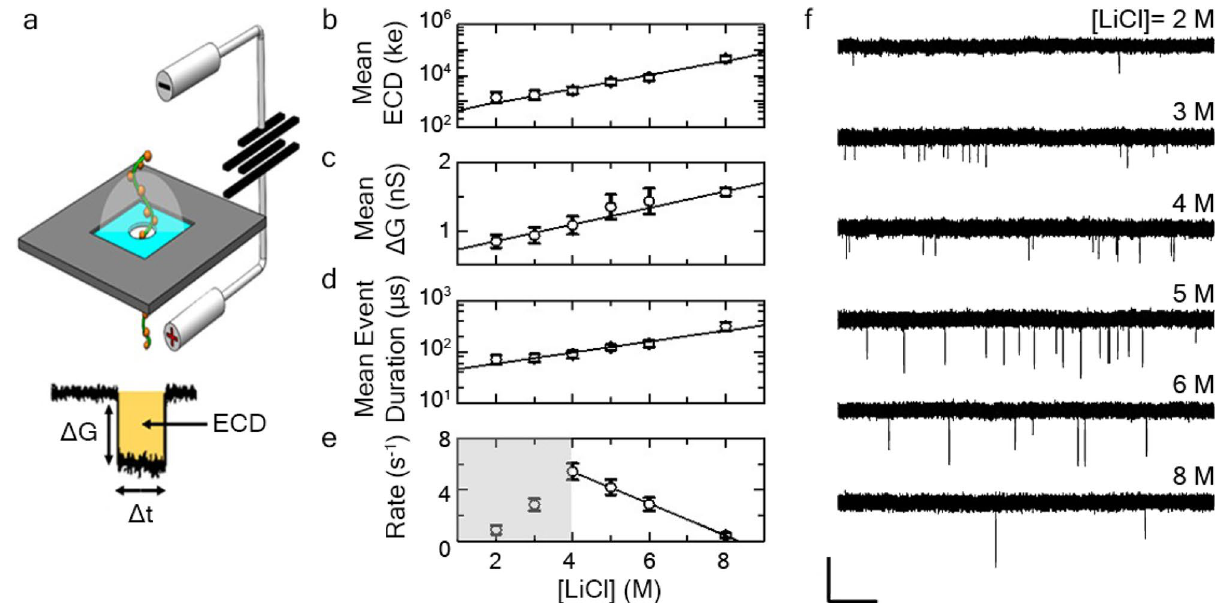
Figure 1. ( a ) Schematic representation of HA translocation through a SS-nanopore. Inset: typical event profile with amplitude (ΔG), event duration (Δt), and integrated area (ECD, shaded yellow) indicated. SS-nanopore results under varying symmetric LiCl concentrations, displaying mean values of ( b ) ECD, ( c ) conductance change, ( d ) event duration, and ( e ) event rate. Solid lines are exponential ( b , d ) or linear ( c , e ) fits to the data and error bars represent measurement standard deviation. All measurements were performed at an applied voltage of 200 mV using quasi-monodisperse 237 kDa HA at a concentration of 2.5 ng/µL using SS-nanopores with diameters of 7–9 nm. At least 1000 events were considered for each data point. ( f ) Representative current traces obtained at different symmetric LiCl concentrations (Top to bottom: 2, 3, 4, 5, 6, and 8 M). Scale bars represent 2 nS (vertical) and 250 ms